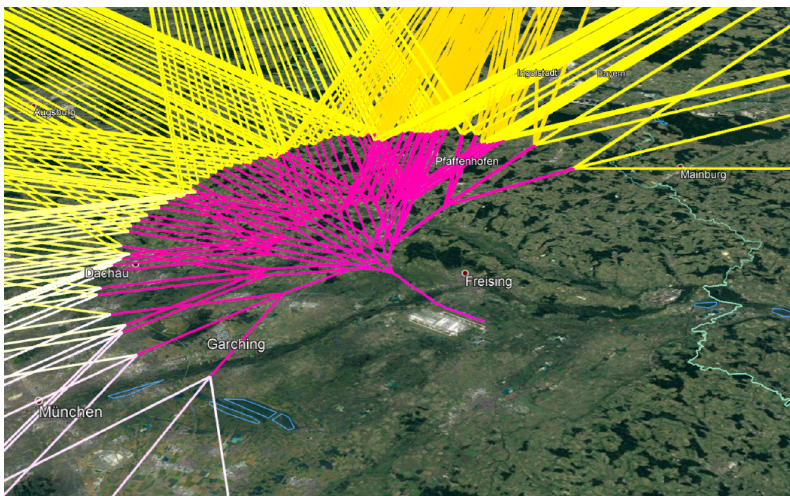
Figure 4. 3D departure search grid from Munich’s runway 26R to a northern destination with θ = 30 ◦ , ˙ ψ s = 3 ◦ s − 1 and A = { h 1 , . . . , h 6 } optimization altitudes. The color indicates the altitude through the SAD -dependent estimated costs to destination (magenta highest). Map: Google, ©2021,